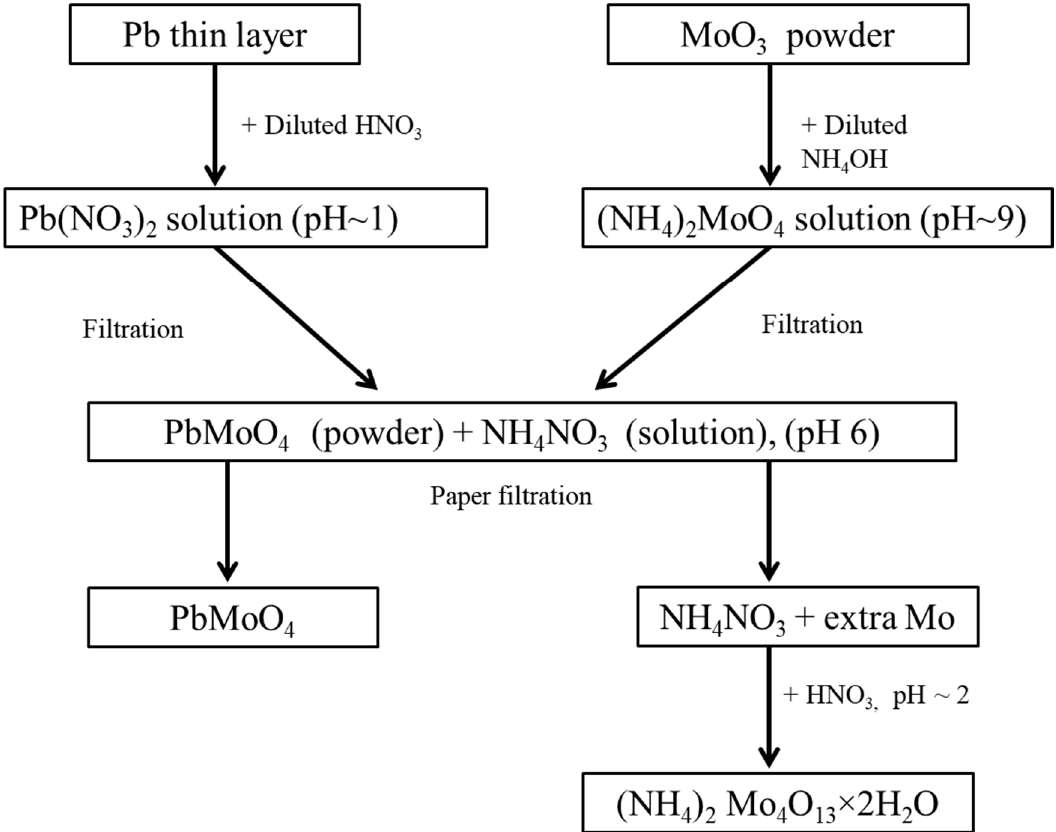
Figure 1. Flow chart of the necessary steps employed for the synthesis of PMO powder.